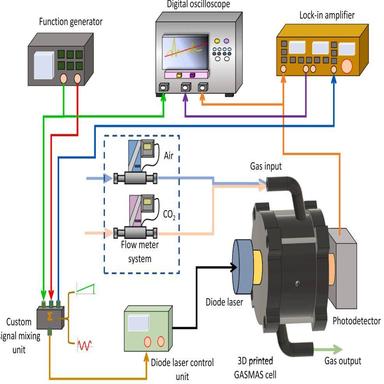
Experimental apparatus and scheme of the GASMAS measurement.